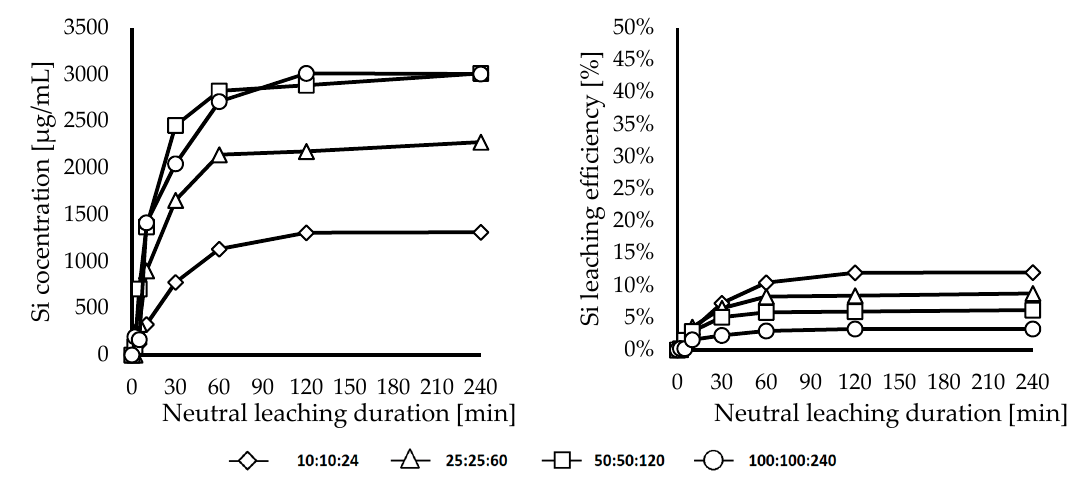
Figure 23. Silicon concentration and leaching efficiency.